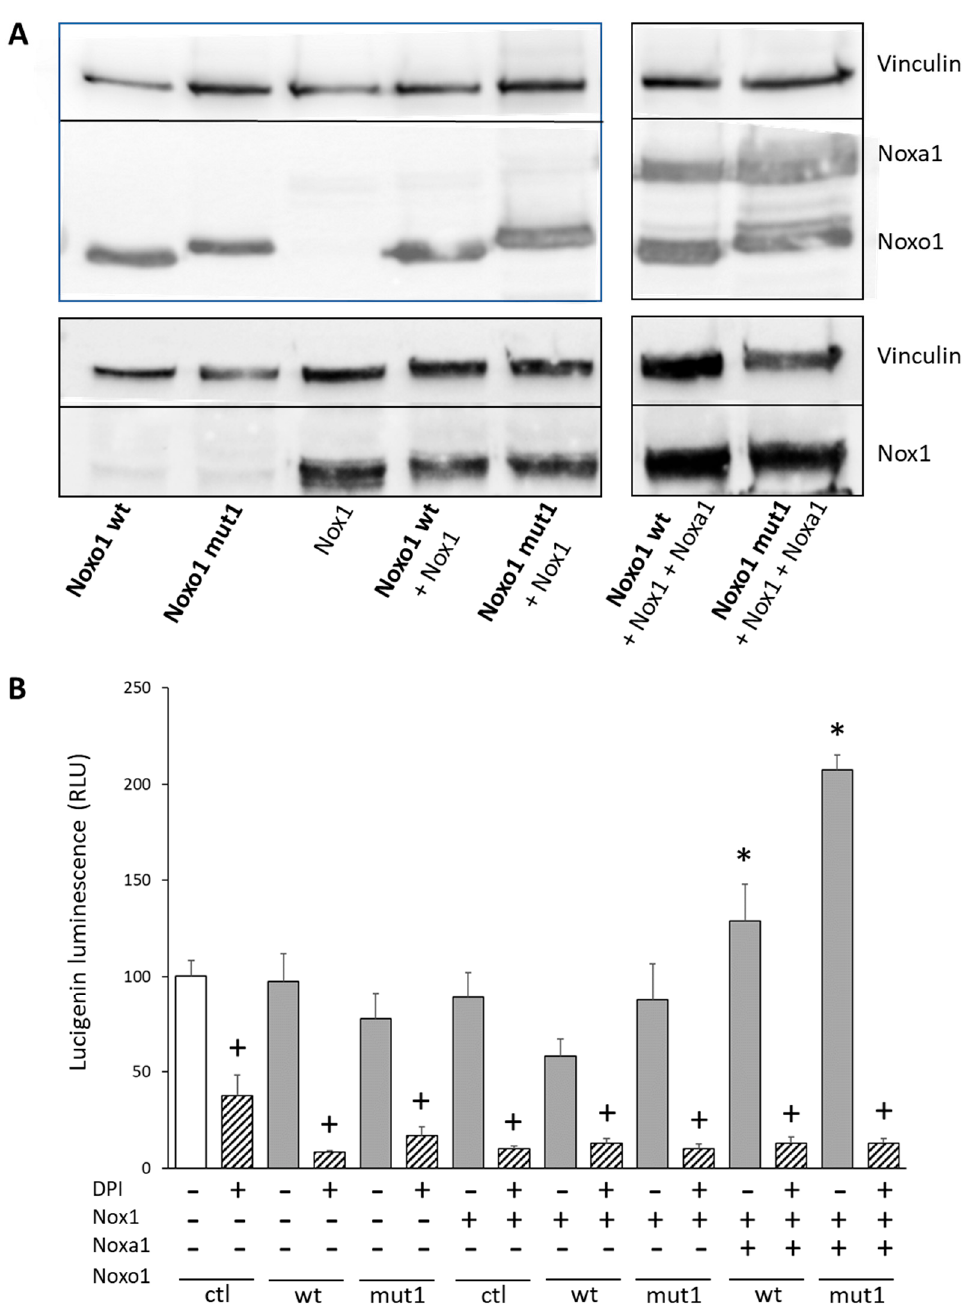
Figure 7. Mut1 Noxo1 increases ROS production in HEK293 cells expressing Nox1-dependent NADPH oxidase complex. ( A ) Immunoblot of Nox1-dependent NADPH oxidase complex reconstitution. Nox1 was revealed by an anti-Nox1 antibody, Noxo1 and Noxa1 were revealed using an anti-DDK antibody. Vinculin was used as the loading control. Lysis was performed in Laemmli buffer. ( B ) ROS production by HEK293 cells transfected with pCMV6 entry vector (ctl), wt Noxo1-DDK or mut1 Noxo1-DDK along with Noxa1 and Nox1 measured by lucigenin luminescence. Results represented mean +/ − S.E.M percentage of ctl (lane 1) issued from four independent experiments realized in triplicate. In some assay DPI (10 µM, 45 min), a flavoprotein inhibitor known to inhibit Nox1 was used. Both wt Noxo1 or mut1 Noxo1 in the presence of Nox1 and Noxa1 increase ROS production. Mut1 Noxo1 is more potent than wt Noxo1 in inducing ROS production. * p < 0.05 compared to ctl (lane1); + p < 0.05 compared without inhibitor.